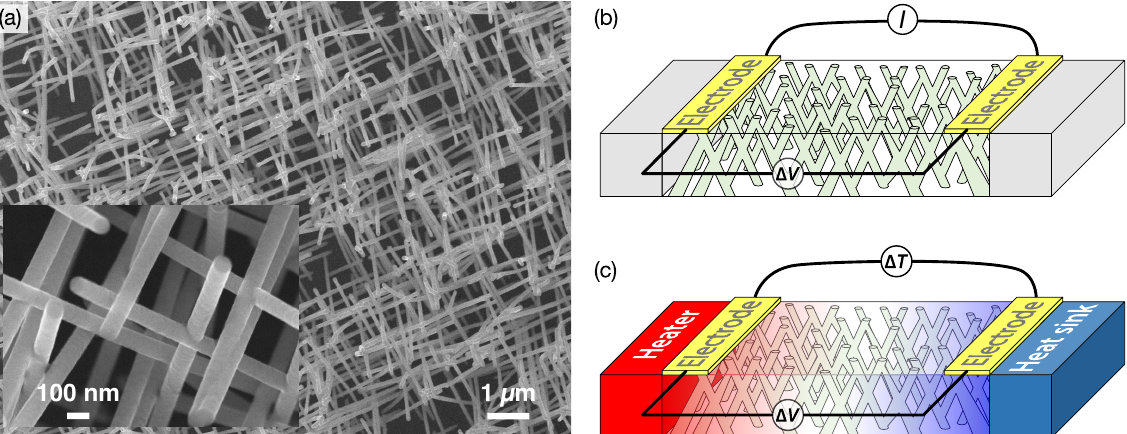
Figure 1. ( a ) Low-magnification SEM image of the interconnected NiFe/Cu NW network film, 80 nm in diameter and about 3% in packing density. The inset shows the branched structure of the NWs, at higher magnification. The diagram shows the experimental set-up for the measurements of ( b ) the electrical resistance and ( c ) the Seebeck coefficient of 3D interconnected NW network